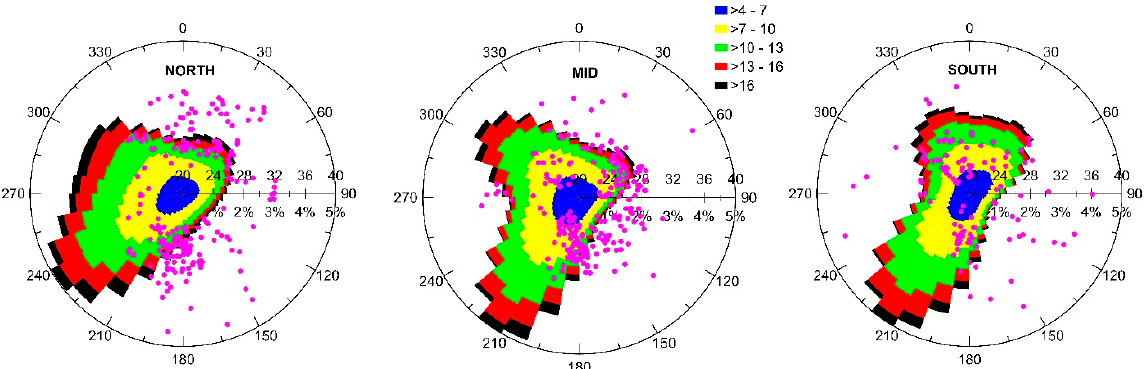
Figure 3. Mean wind roses for hourly output (1979–2018) at 100 m height from ERA5 for the three groups of LA (see Table 2; NORTH shows LA 1–7, MID shows LA 8–13 and SOUTH shows LA 14–16). The colored areas show the frequency by direction (in 10° bins) of wind speeds in the classes shown in the legend (in ms − 1 ). The frequency (in %) is given below the radial axis (from 0–5%). The magenta symbols show the annual maximum wind speeds ( U max ) where the wind speed value is given (in ms − 1 ) above the radial axis (from 20–40 ms − 1 ).